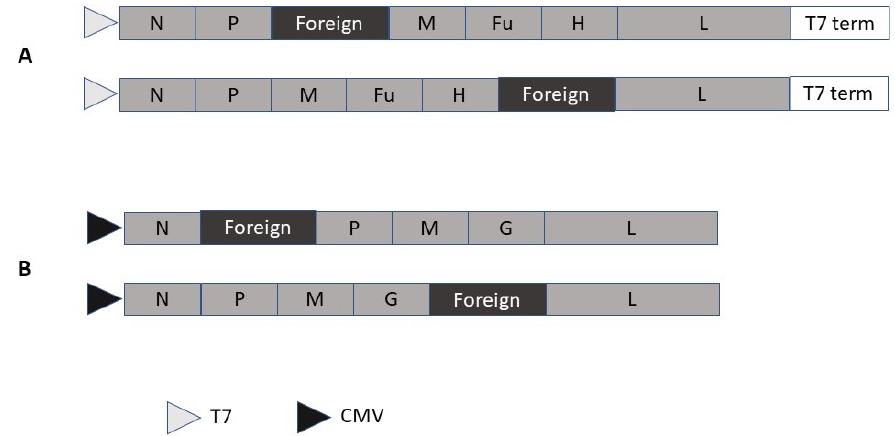
Figure 2. Self-replicating rhabdovirus and measles virus vectors. ( A ) Rabies virus vector with alternative insertion sites for foreign genes. ( B ) Measles virus vector with alternative insertion sites for foreign genes. CMV, cytomegalovirus; Fu, Measles virus fusion protein; G, Measles virus G protein; H, Measles virus hemagglutinin; L, Rabies or measles virus L protein; M, Rabies or measles virus matrix protein; N: Rabies or measles virus nucleocapsid protein; P, Rabies P or measles virus phosphoprotein; T7, phage T7 RNA polymerase promoter; T7 term, phage T7 terminator sequence.